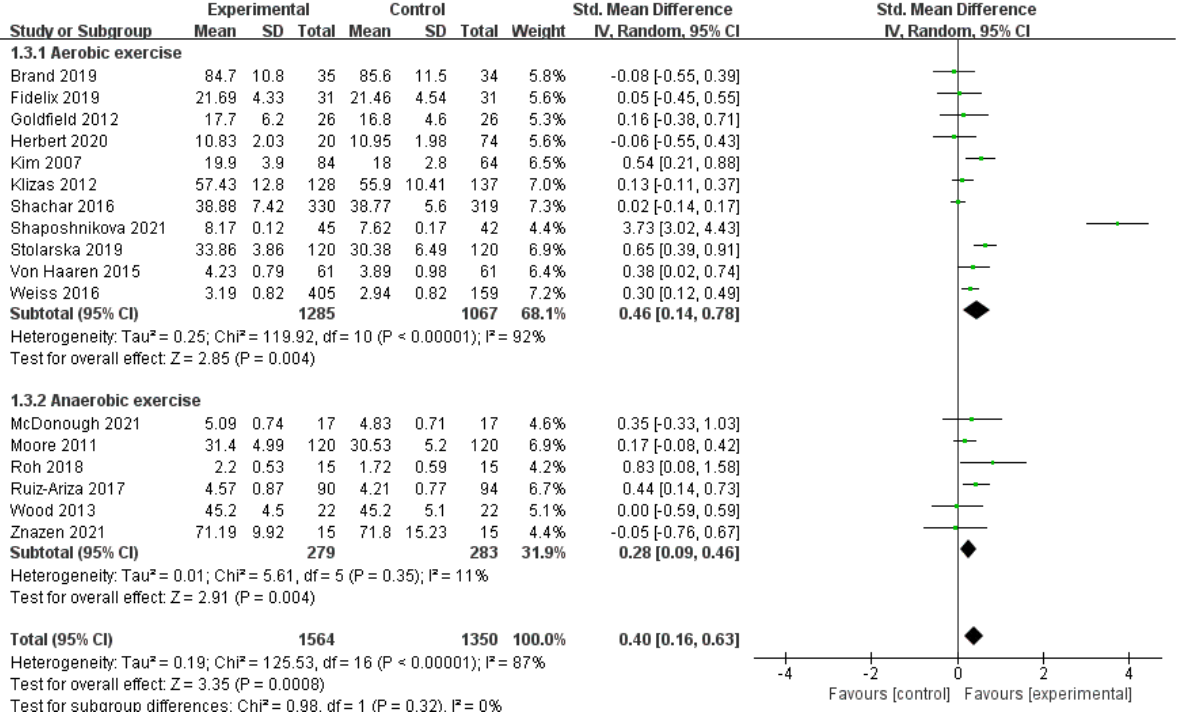
Figure 4. Exercise type subgroup of the association between PA and positive emotions in children and adolescents [30–34,36,38,39,41,43–47,49–51]. Duration of